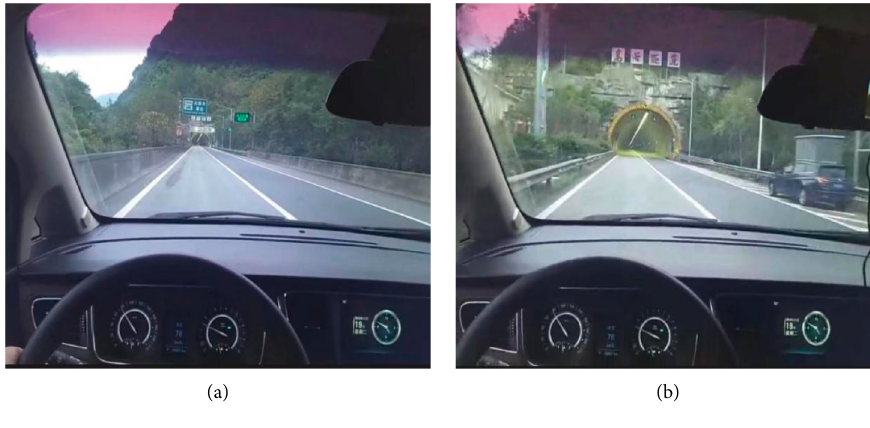
Figure 1: Gaogu Long